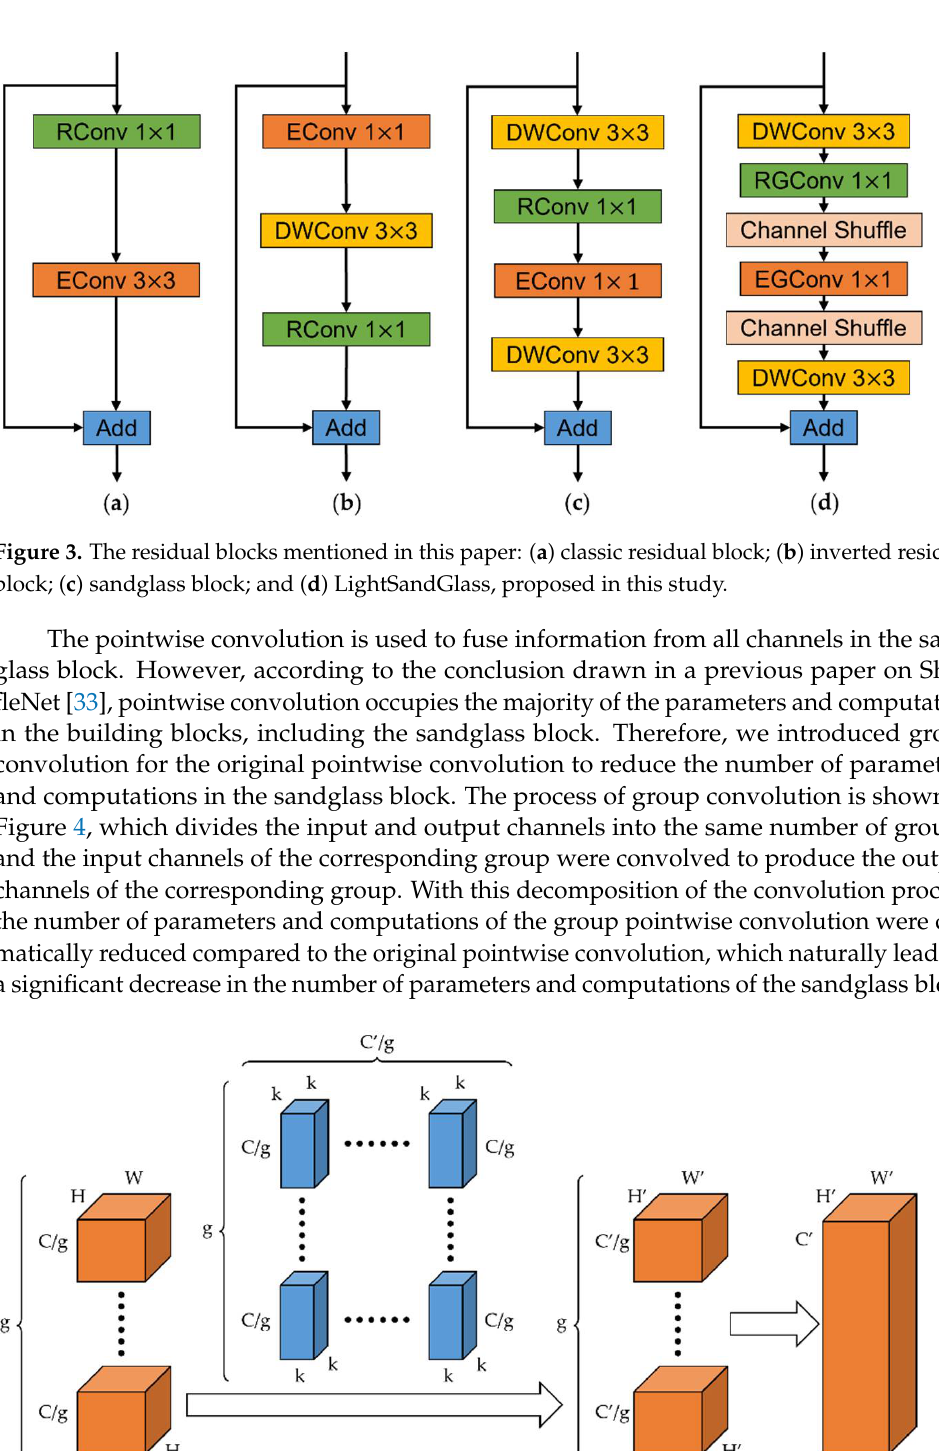
Figure 4. The process of group convolution.